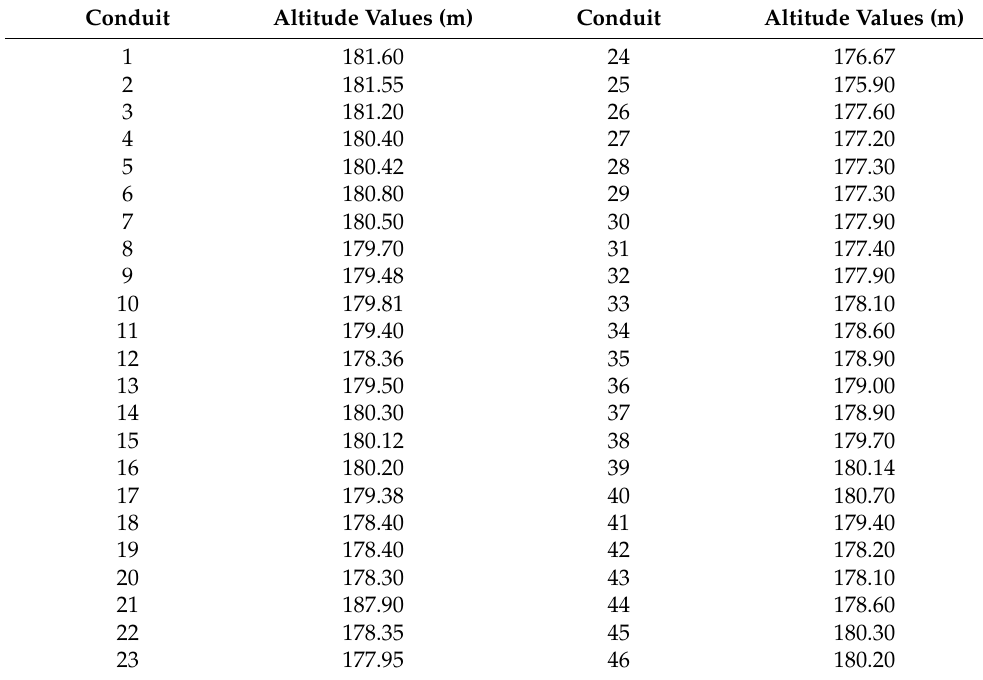
Table 3. Altitude values of the top of each visible water conduit.